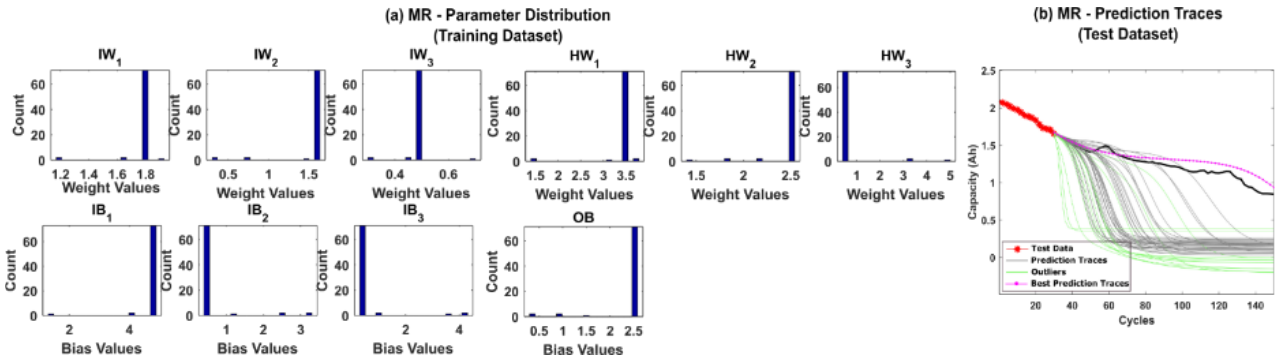
Figure 11. ( a ) The posterior distribution of MLP network parameters estimated by the adaptive Bayesian learning framework using MR and ( b ) the degradation prediction traces for NASA battery (RW-11) using MR. The prediction traces for 50 repetitions are shown using the gray lines, the green lines represent outliers, and the magenta lines represent the traces with minimum RMSE values.